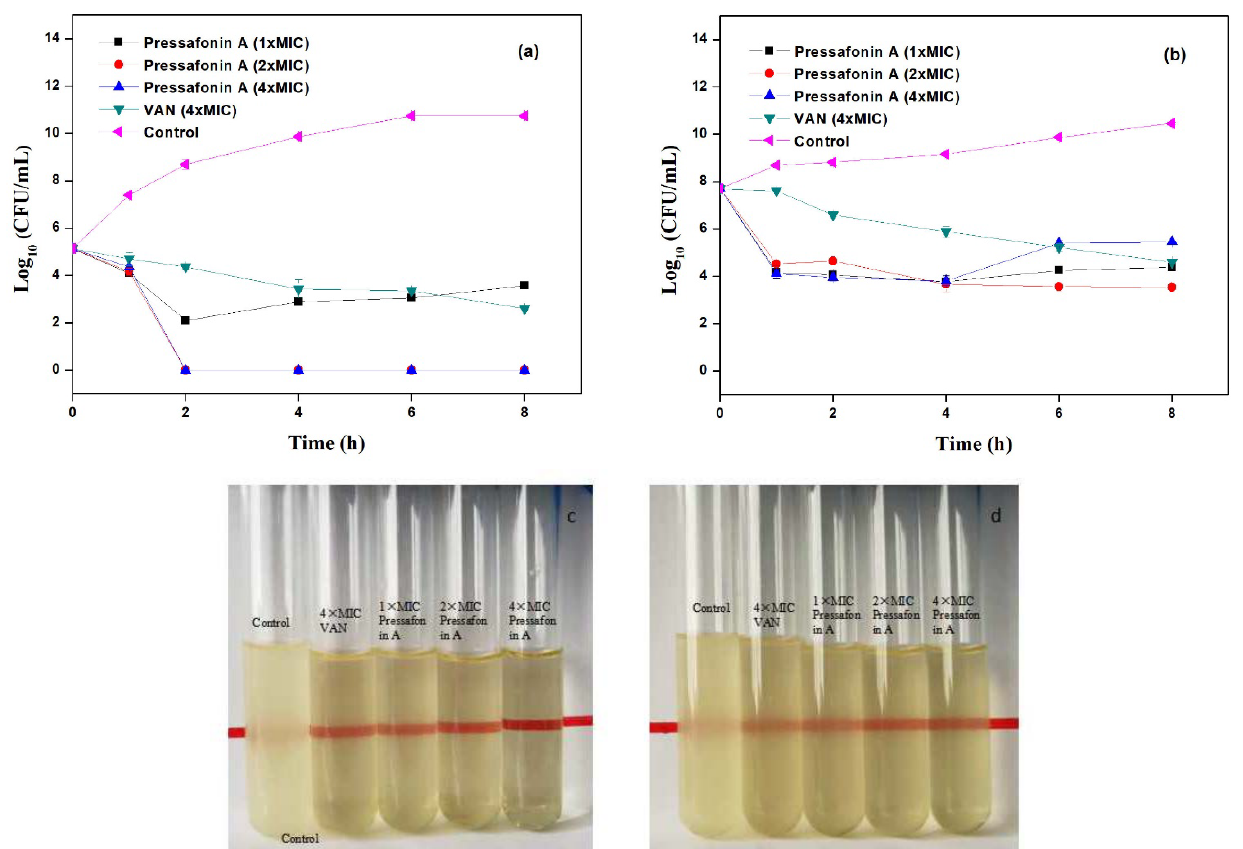
Figure 2. Time-dependent killing of MRSA-3 by compound 6 . ( a , c ) MASA-3 was grown to early exponential phase and was challenged with 6 (at 1×, 2× and 4× MIC) and vancomycin (at 4× MIC); ( b , d ) MASA-3 was grown to stationary exponential phase and was challenged with 6 (at 1×, 2× and 4× MIC) and vancomycin (at 4× MIC); ( c , d ) the bacterial suspension after treatment with compound 6 for 8 h. The control was treatment with sterile water.